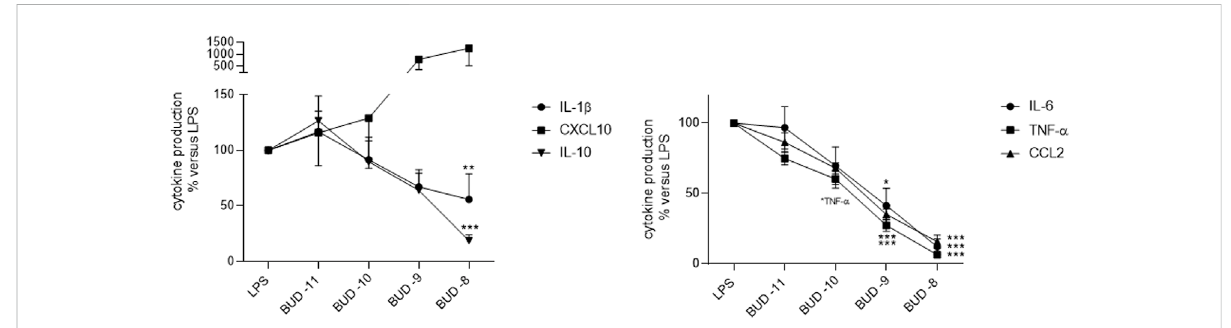
FIGURE 2 Effect of budesonide on the LPS-induced production of cytokines by LMs. The cells were treated with budesonide (at concentrations ranging from 10 – 11 to 10 – 8 M) before stimulation with LPS (10 ng · ml − 1 ) for 24 h. The mean ± SEM results of fi ve to eight independent experiments are expressed as a percentage of the response to LPS. Asterisks indicate signi fi cant differences relative to LPS (*: < 0.05; **: < 0.01; ***: < 0.001).